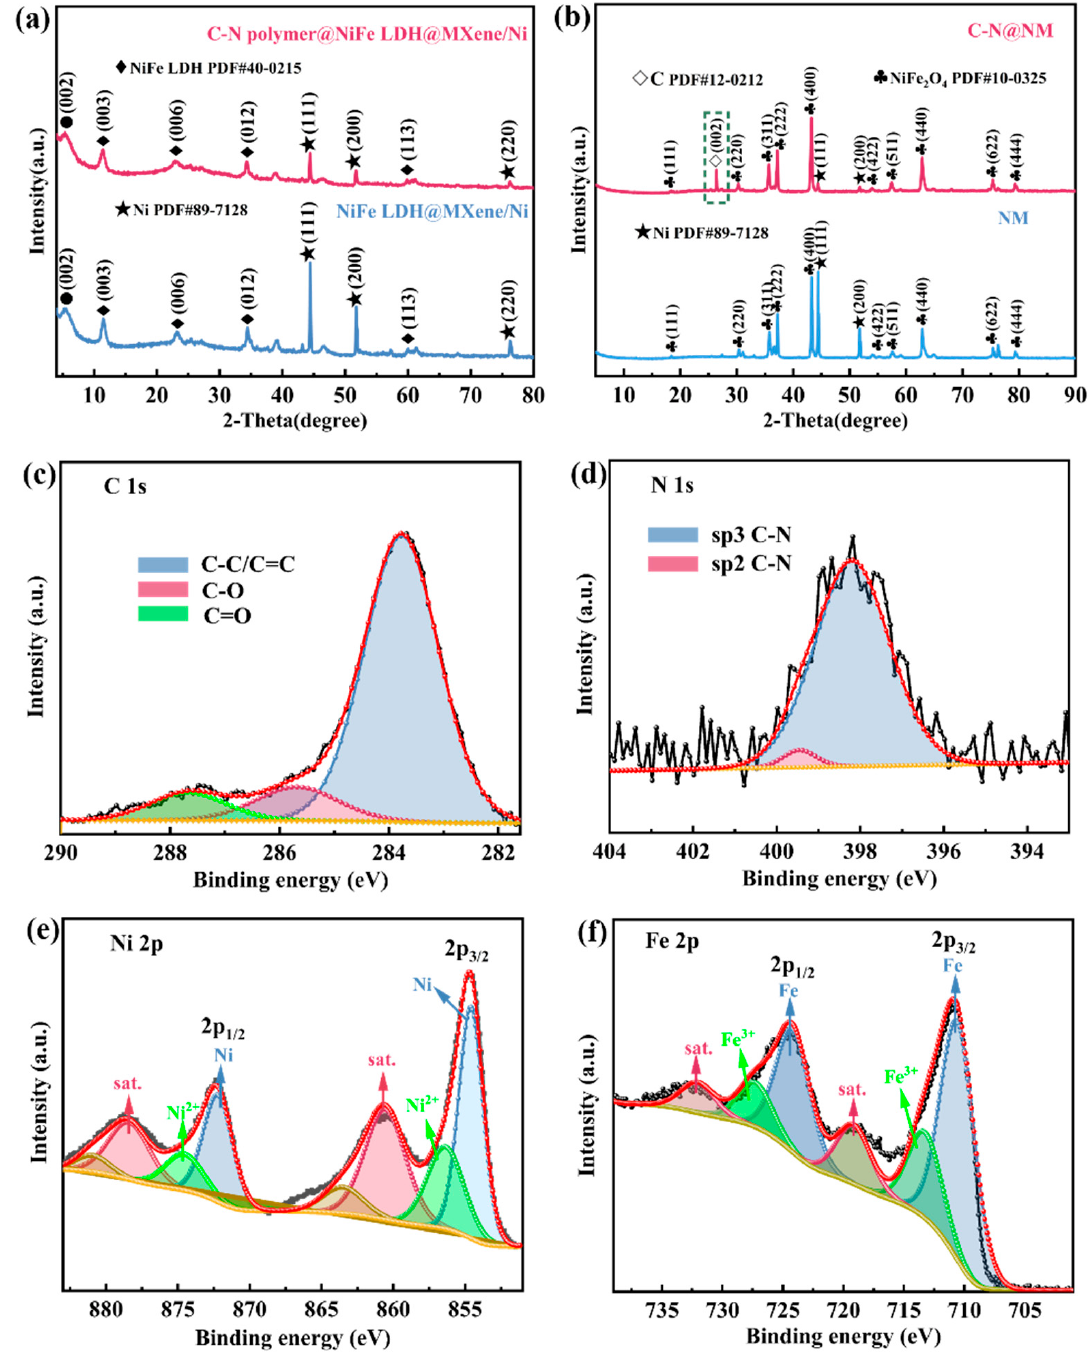
Figure 1. XRD patterns: ( a ) NiFe LDH@MXene/Ni and C-N polymer@NiFe LDH@MXene/Ni, ( b ) NM and C-N@NM; XPS spectra of C-N@NM: ( c ) C 1s; ( d ) N 1s; ( e ) Ni 2p; ( f ) Fe 2p.